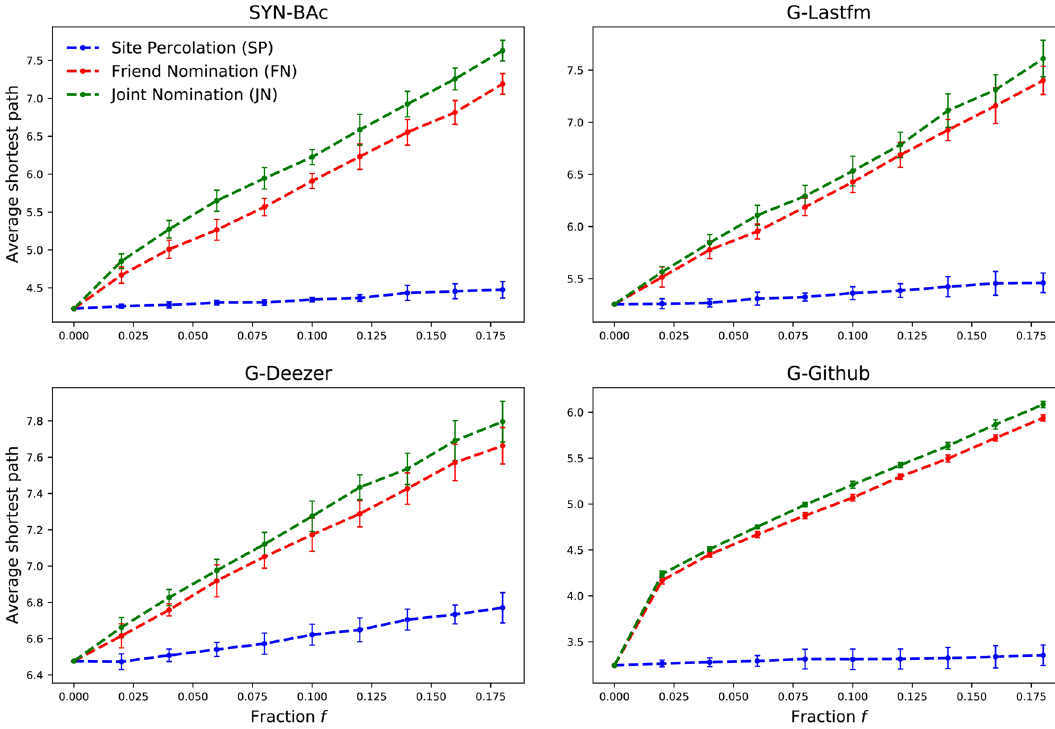
Figure 6. The average shortest path length of the remaining network after nodes removal with SP, FN and JN. The results are averaged over 50 independent